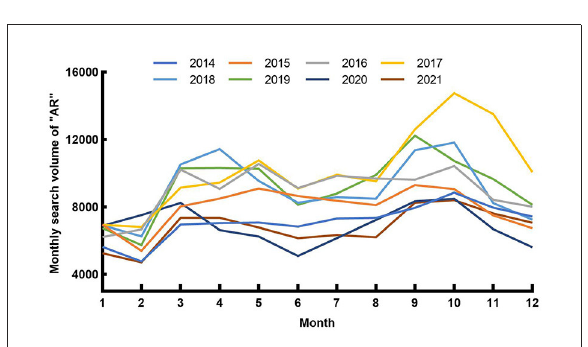
FIGURE2 Epidemiological characteristics of “AR” in Wuhan from 2014 to